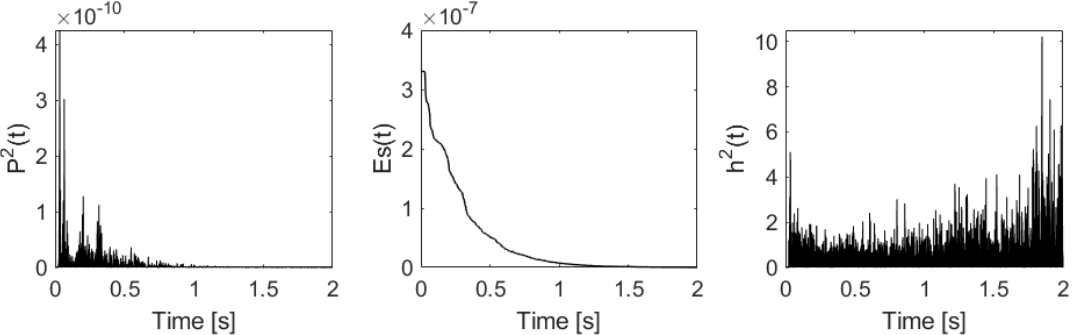
Figure 1. A squared impulse response (( p 2 ( t ) ), a Schroeder decay curve ( E S ( t ) ) and a squared decay-cancelled impulse response ( h 2 ( t ) ) measured in an empty reverberation room at 1000 Hz for DTF